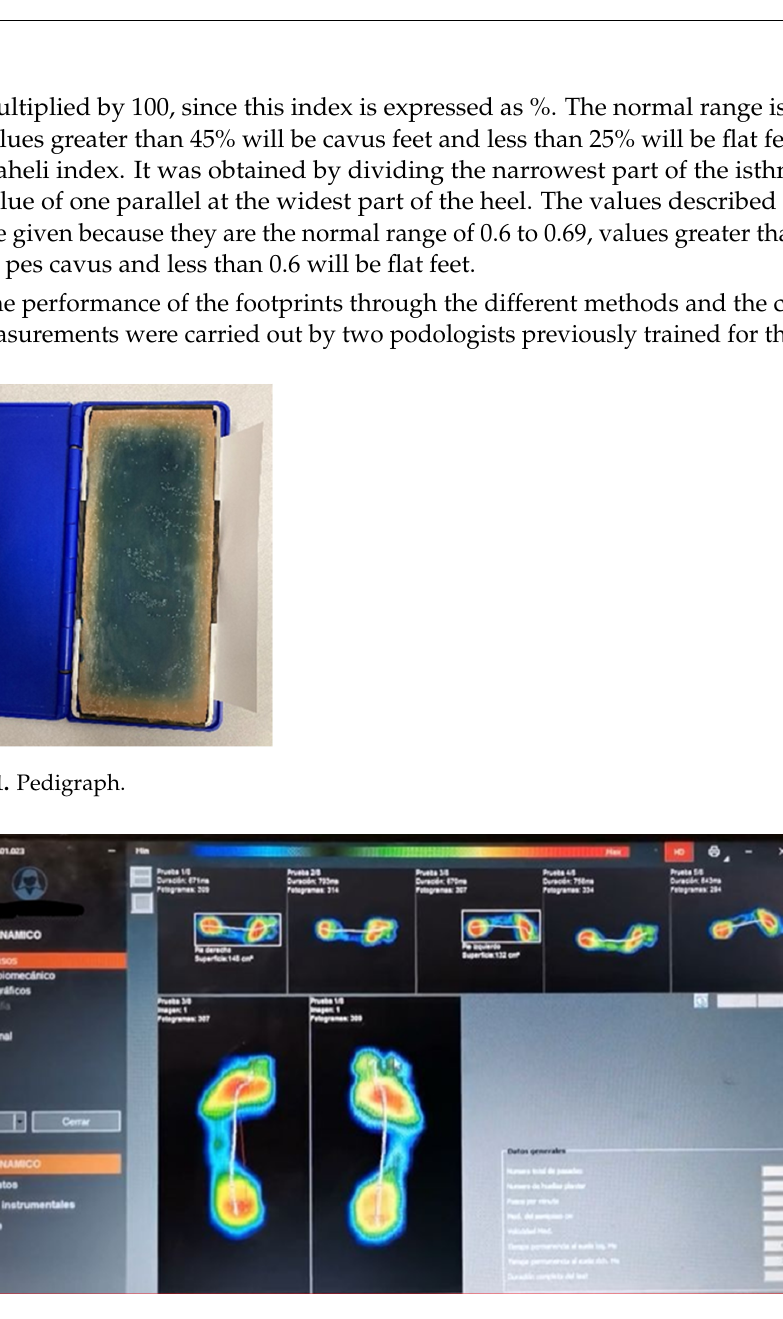
Figure 2. Study of the plantar footprint using the pressure platform.